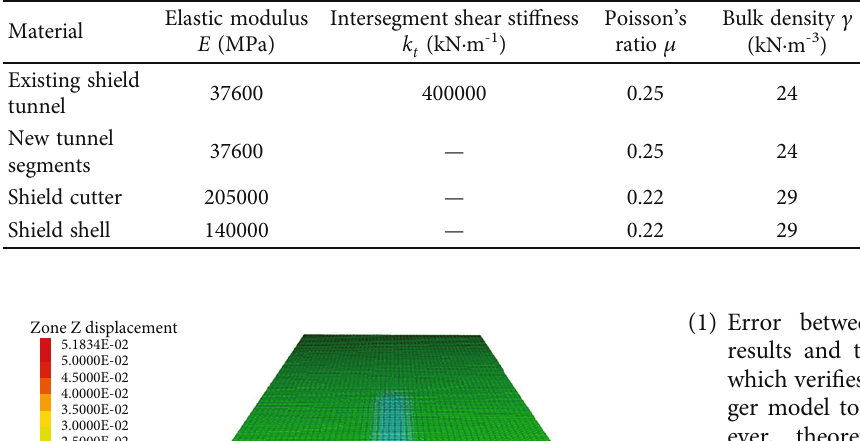
Table 3: Physical and mechanical parameters of existing shield tunnel.